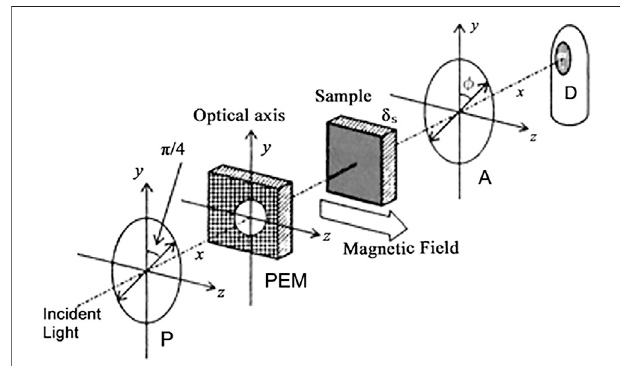
FIGURE 15 | Experimental setup for measurement of Cotton Mouton effect, which consists of a polarizer P, a photo-elastic modulator PEM, a sample, an analyzer A, and detector